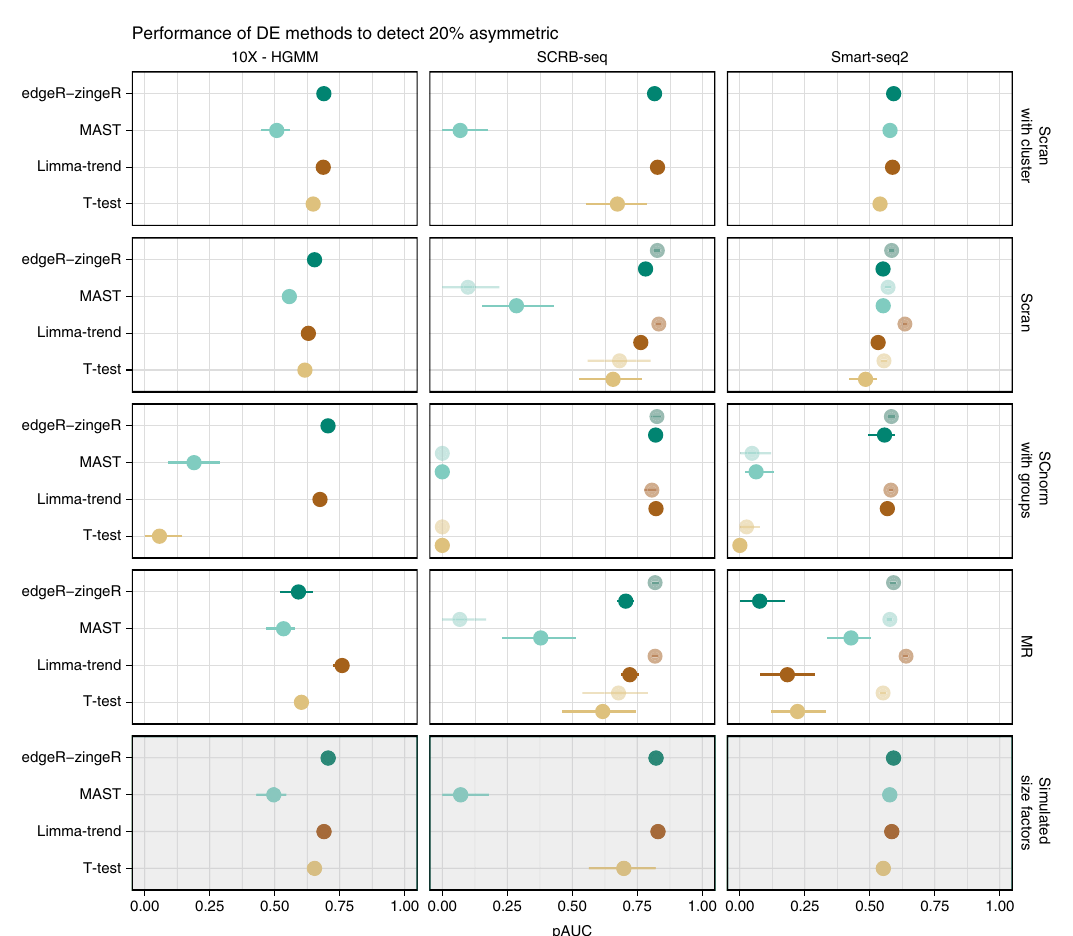
Fig. 4 Evaluation of DE tools. The expression of 10,000 genes over 768 cells (384 cells per group) were simulated given the observed mean-variance relation per protocol. Twenty percent of the simulated genes are differentially expressed following an asymmetric narrow gamma distribution. Un fi ltered counts were normalised using simulated library size factors or applying normalisation methods. Differential expression was tested using T -Test, limma- trend, MAST or edgeR-zingeR. The discriminatory ability of DE methods is determined by the partial area under the curve (mean pAUC ± s.d.) for the TPR- FDR curve (see also Supplementary Figs. 19 –